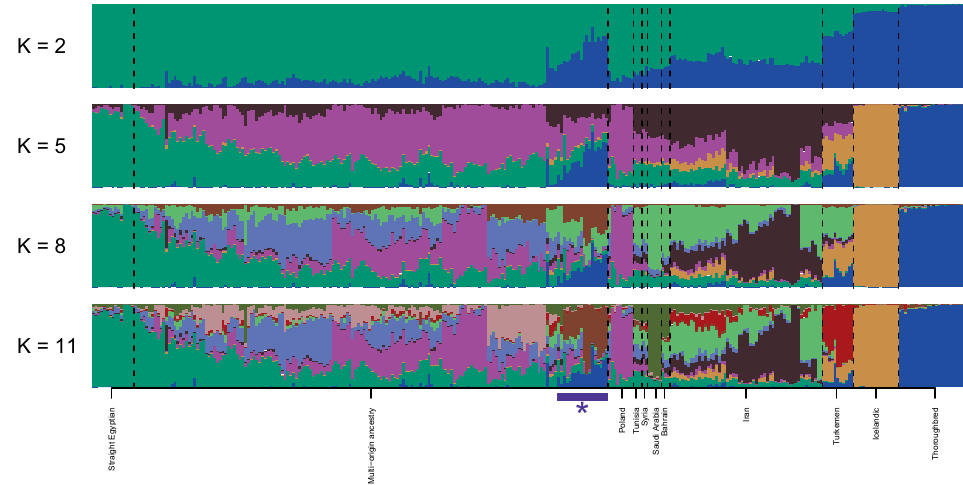
Figure 3. Individual lineages of the Arabian breed display complex ancestry. STRUCTURE cluster assignments are plotted for number of clusters K = 2, 5, 8, and 11 (top to bottom panels). Each cluster in a given analysis (panel) is represented by a separate color. The plotted 312 samples represent Arabian breed subgroups as well as Turkemen, Icelandic and Thoroughbred breeds. Sample order is the same in each panel. 47,436 SNPs were included in the analysis. The purple bar and asterisk mark the cluster of multi-origin samples showing shared ancestry with Thoroughbred